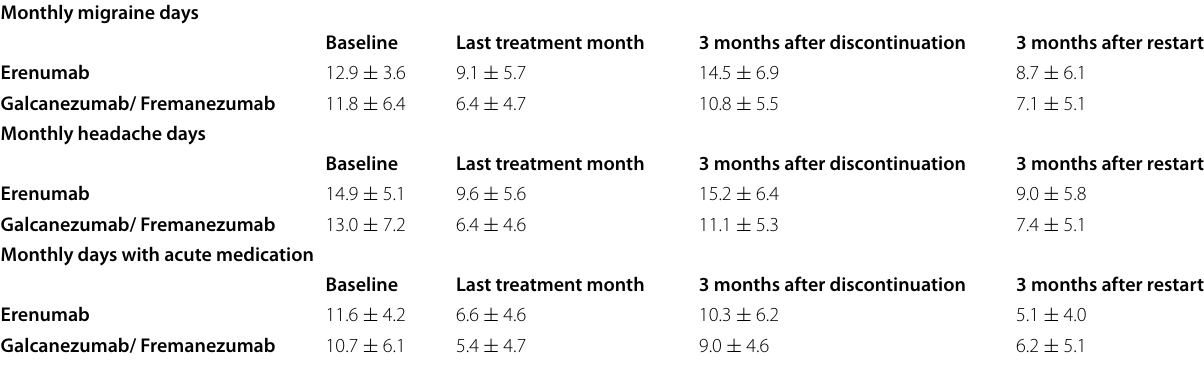
Values are mean standard deviation (descriptive values, statistical significance is not provided) ±